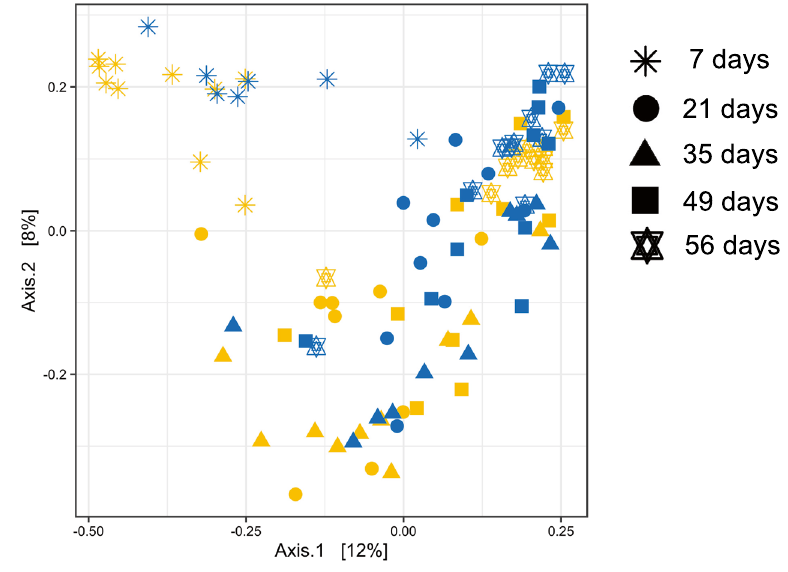
Figure 1. Change in the ruminal bacterial community structure in calves from 7 to 56 days of age. The PCoA plot was generated based on Bray–Curtis dissimilarities of rumen bacterial community determined via 16S rRNA gene amplicon sequencing. Colors indicate the dietary groups; control (yellow) and treatment (blue). Different symbols represent different age points. Individual points represent individual animals. P -values of the effect of dietary group ( P < 0.001), calf age ( P < 0.001), and diet × age interaction ( P < 0.01) was calculated using the PERMANOVA